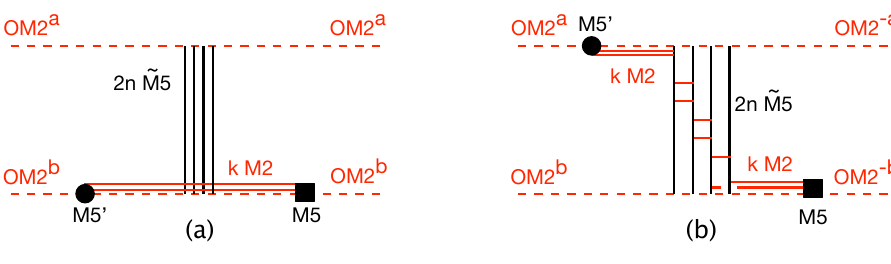
Figure 7 . M-brane con(cid:12)gurations with an even number of (cid:13)avor branes for O ( K ) and USp(2 k )